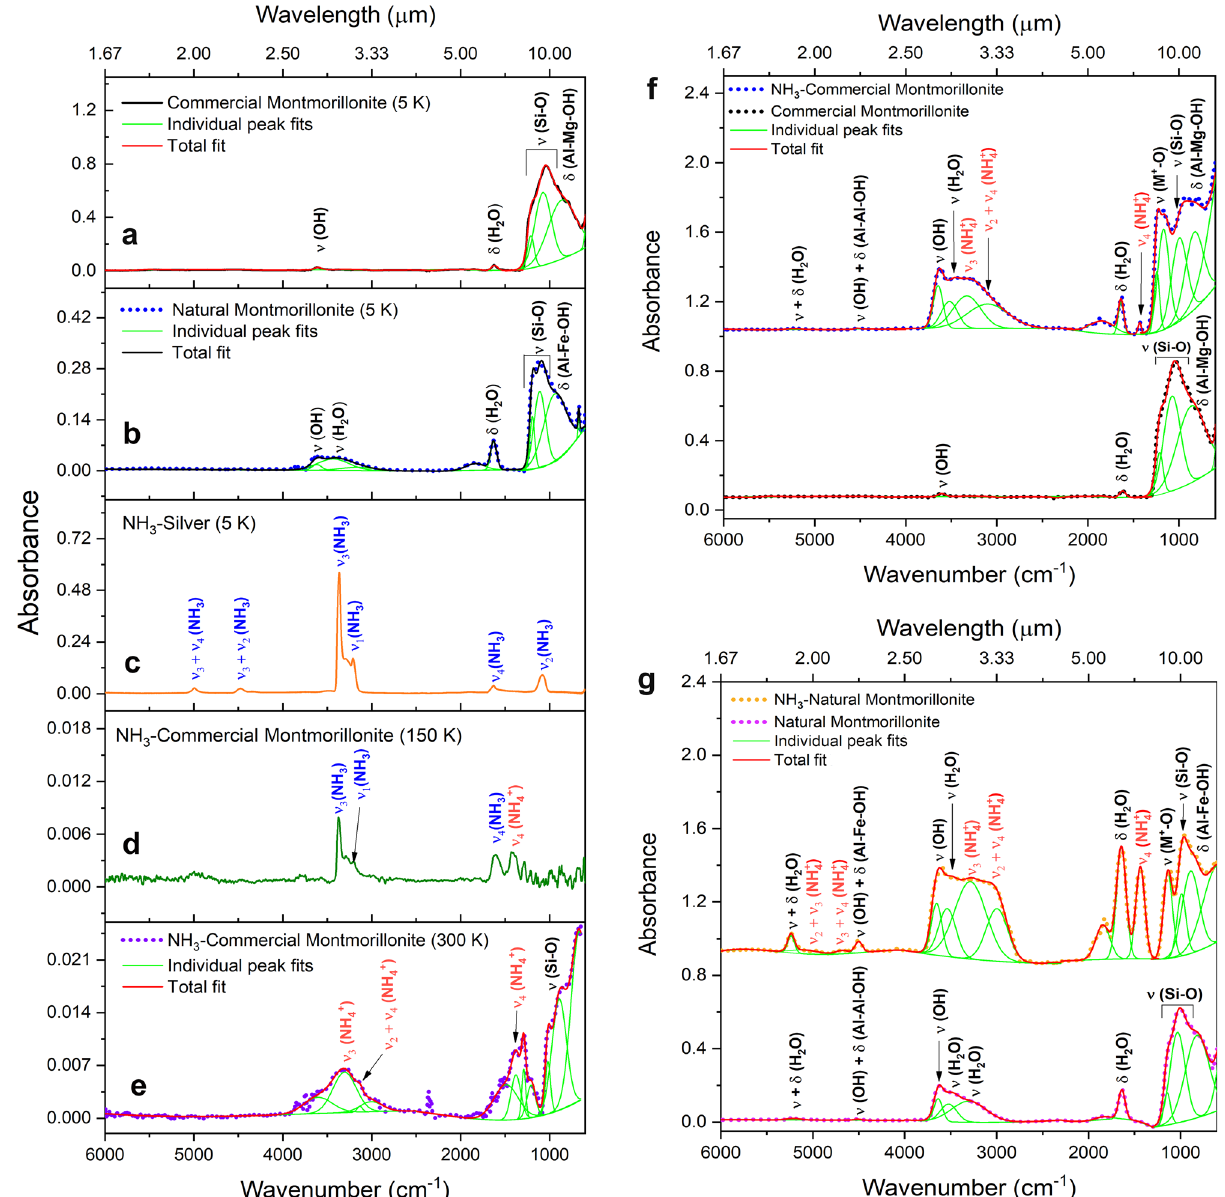
Fig. 1 Infrared (IR) spectra of treated and untreated montmorillonite samples with ammonia. In-situ infrared (IR) spectra of ( a ) commercial montmorillonite, ( b ) natural montmorillonite, and ( c ) ammonia (NH 3 ) ice on a silver substrate at 5 K. IR spectra of ammonia deposited on the surface of commercial montmorillonite at ( d ) 150 K and ( e ) 300 K. ( f ) and ( g ) are ex-situ IR spectra of ammonia-coated commercial and natural montmorillonite measured at 298 K and 1 atm pressure. Broad IR spectra are deconvoluted to identify the individual peak positions. Vibrational modes of chemical species are labeled using symbols ‘ ν ’ and ‘ δ ’ . Detail assignments of the bands are provided in Supplementary Tables S2 – S5. In spectra ( d ) and ( e ) the initial mineral absorptions are subtracted to clearly identify absorptions of ammonia and ammonium